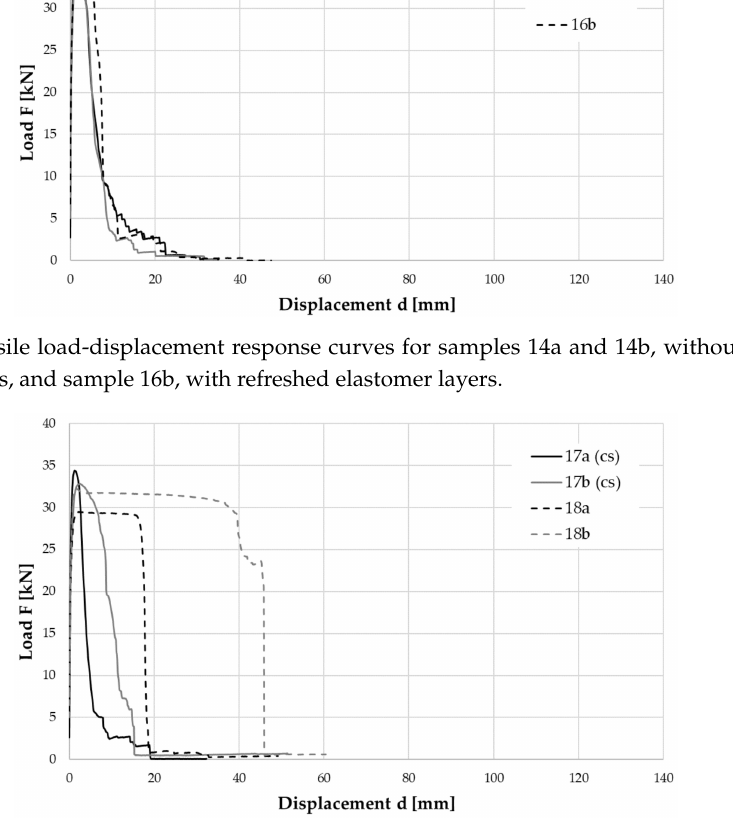
Figure 20. Tensile load-displacement response curves for samples 17a and 17b, without refreshed elastomer layers, and 18a and 18b, with refreshed elastomer